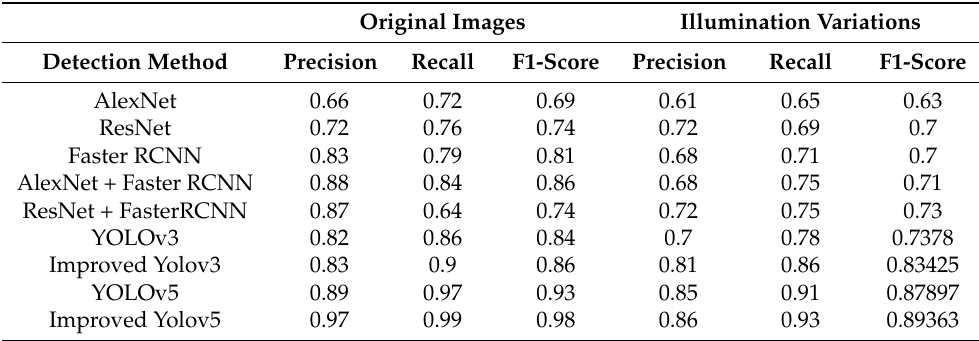
Table 1. Comparative performance for original images and illumination variations. Original Images Illumination